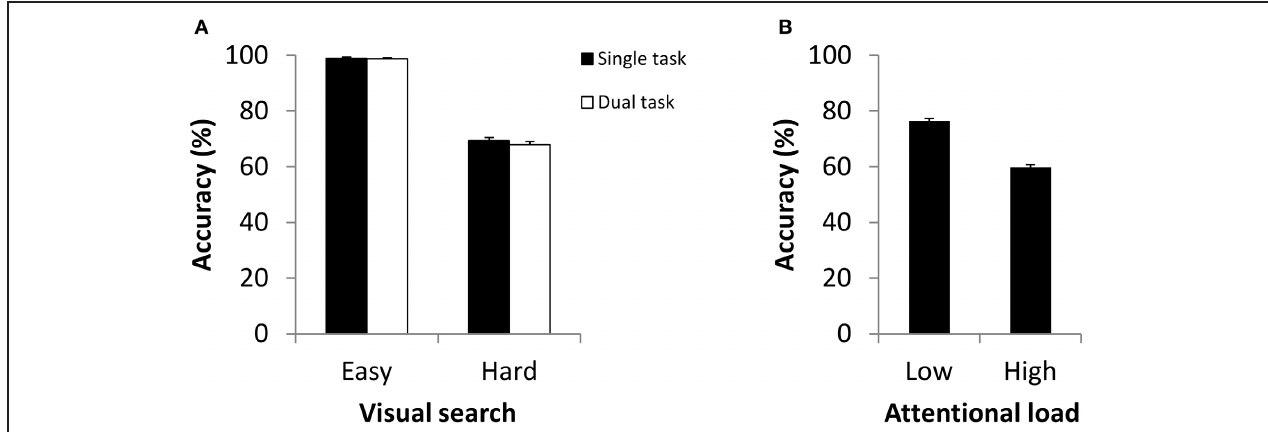
FIGURE 2 | (A) Accuracy for visual search for single and dual tasks as a function of search type in Experiment 1. (B) Change detection accuracy in dual tasks as a function of attentional load in Experiment